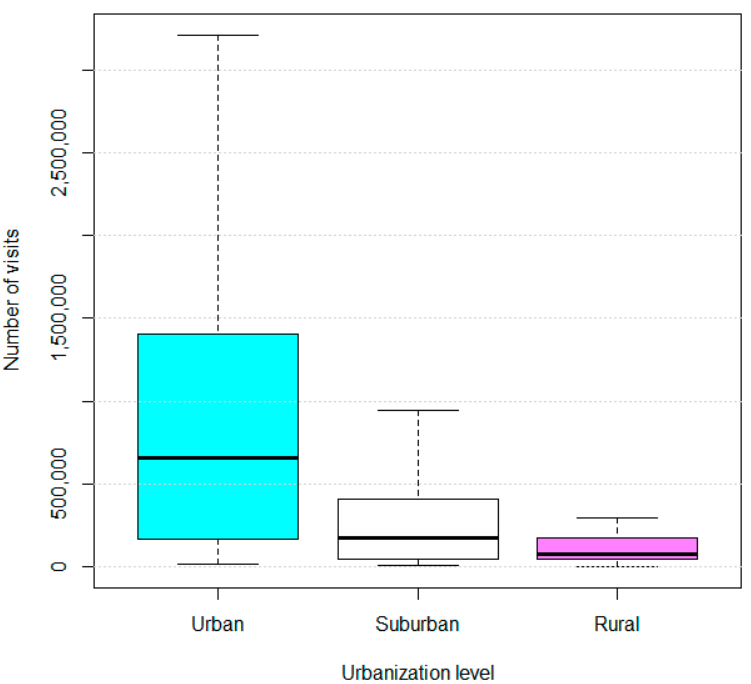
Figure 1. Number-of-visitors distribution of websites of 251 LHCs in Taiwan.